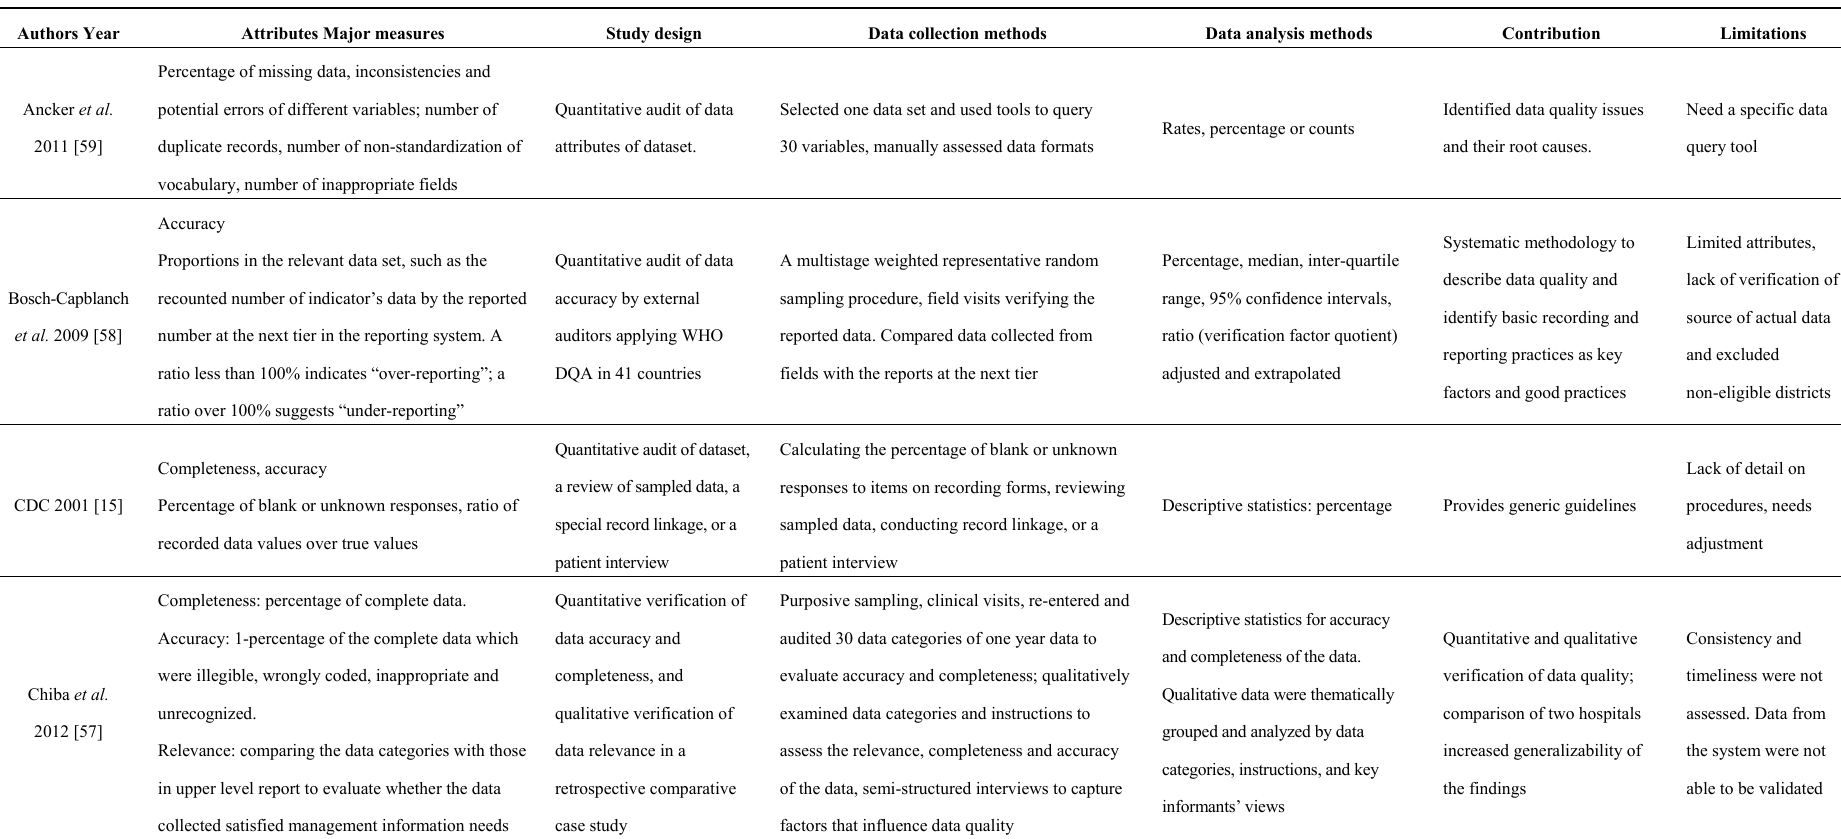
Table A1. Characteristics of methods for assessment of the data dimension reported in the 36 publications included in the